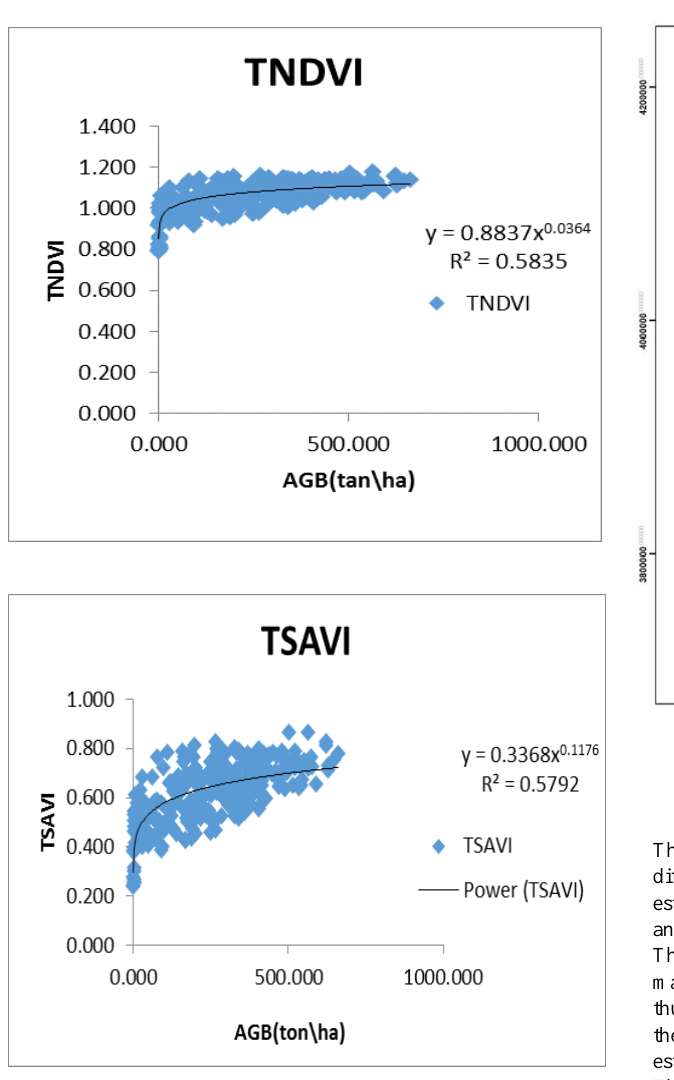
Figure 4. Statistical Analysis between VIs and Observed